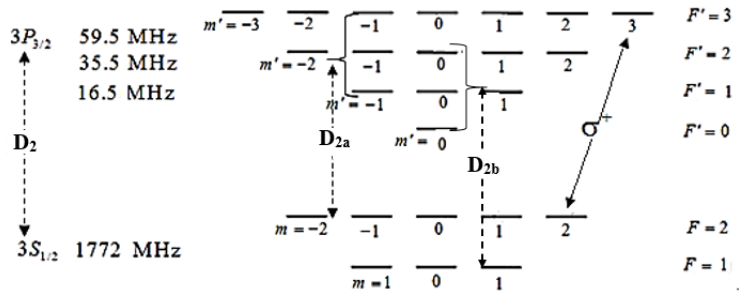
Figure 1. The D 2 hyperfine structure of sodium atom and the two-level